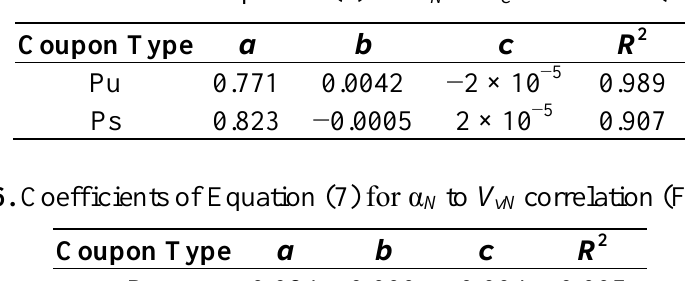
Table 5. Coefficients of Equation (7) for